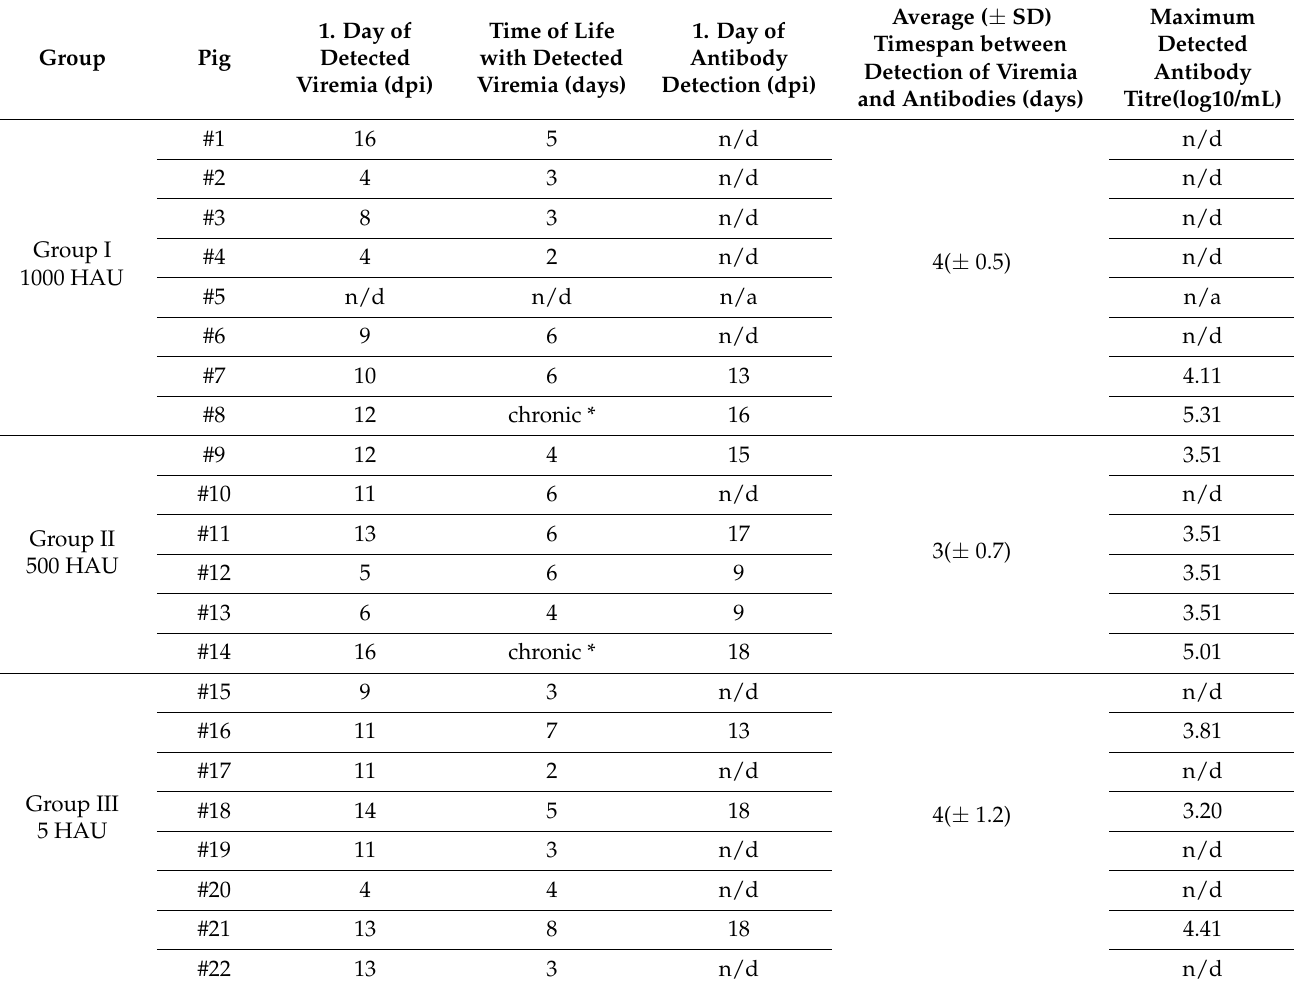
Table 2. Viremia onset and duration, antibody titres, and detection in infected animals during the experiment. Group Pig